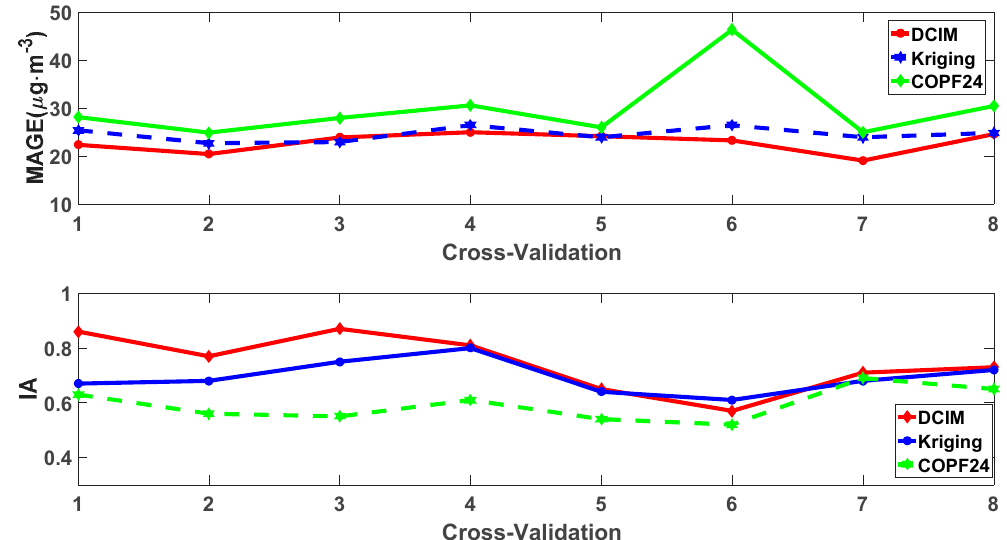
Figure 4. Interpolation errors in checked samples of different methods for the 8-fold cross-validation experiments on 17–20 May 2014.